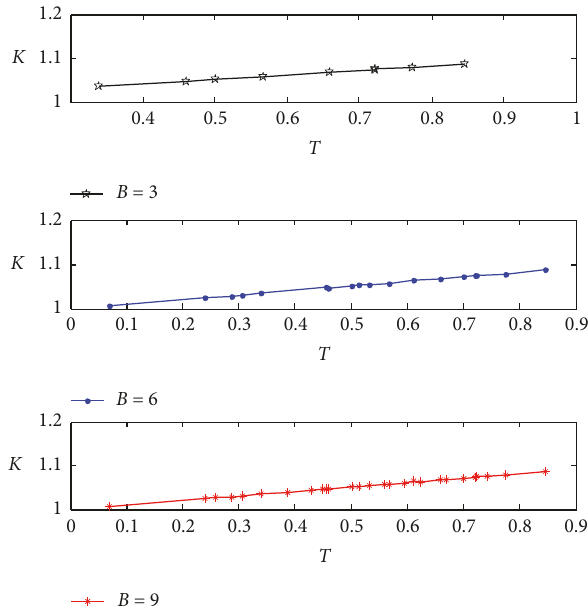
Figure 5: The inversion result of the thermal